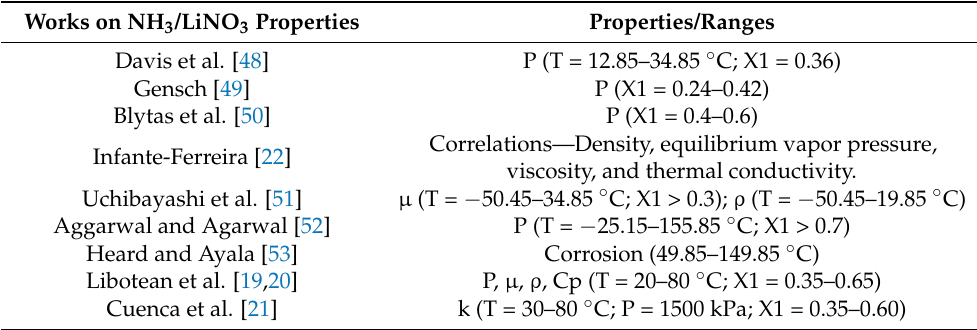
Table 2. State-of-the-art of thermodynamic properties for the NH 3 /LiNO 3 working fluid. Works on NH 3 /LiNO 3